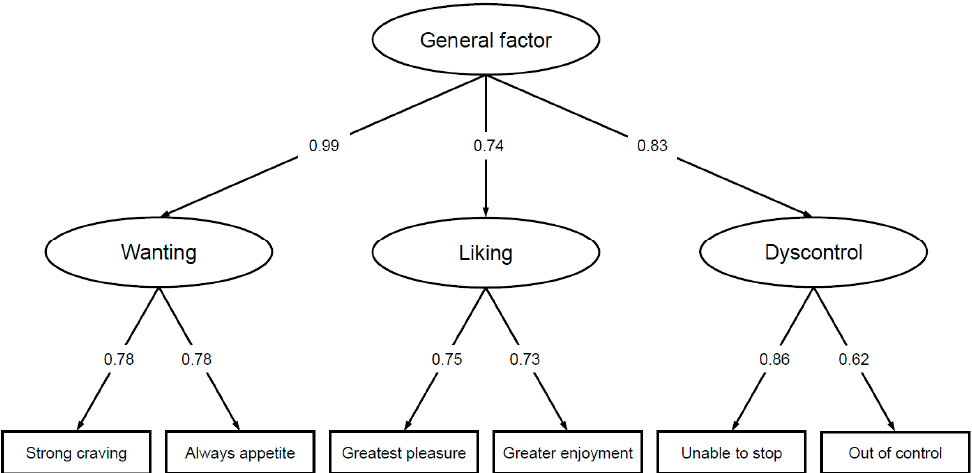
Figure 1. Confirmatory factor analysis of the 6-item Hedonic Overeating–Questionnaire (N = 2531): standardized factor loadings for the first- and second-order factors.